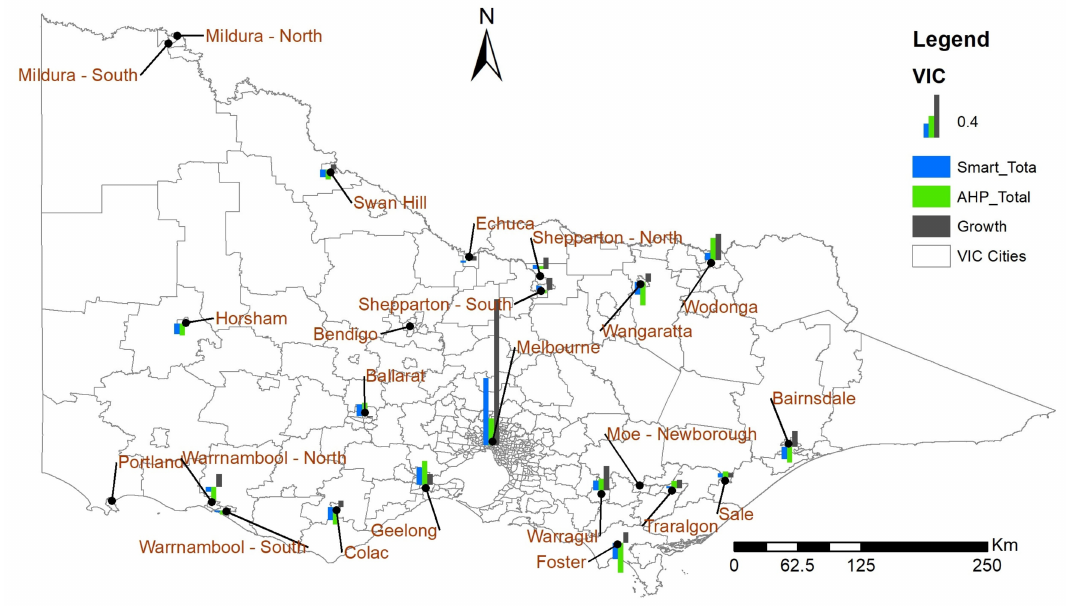
Figure 11. Performance of 23 cities of Victoria in terms of smart score, preference, and population growth. 18 cities from the Queensland were evaluated. Except the Greater Brisbane and Maroochydore–Kuluin (part of Sunshine Coast), all 16 remaining cities performed